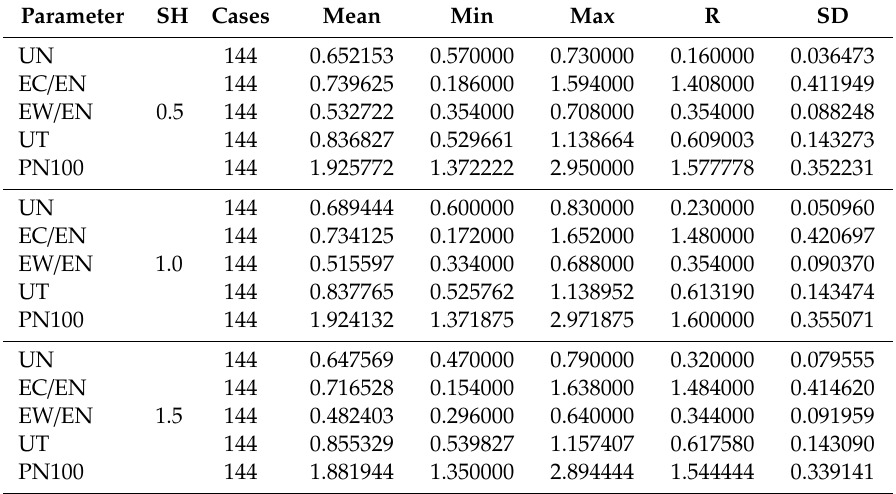
Table 7. Variation of lighting parameters for each luminaire layout (SH